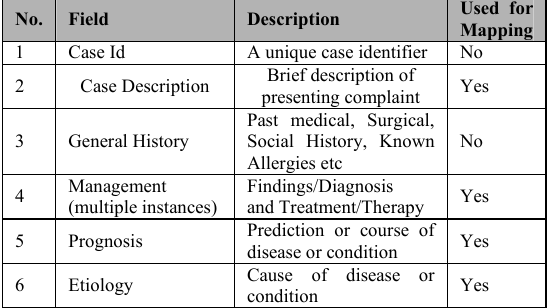
Table 2: Case Structure tags and their description